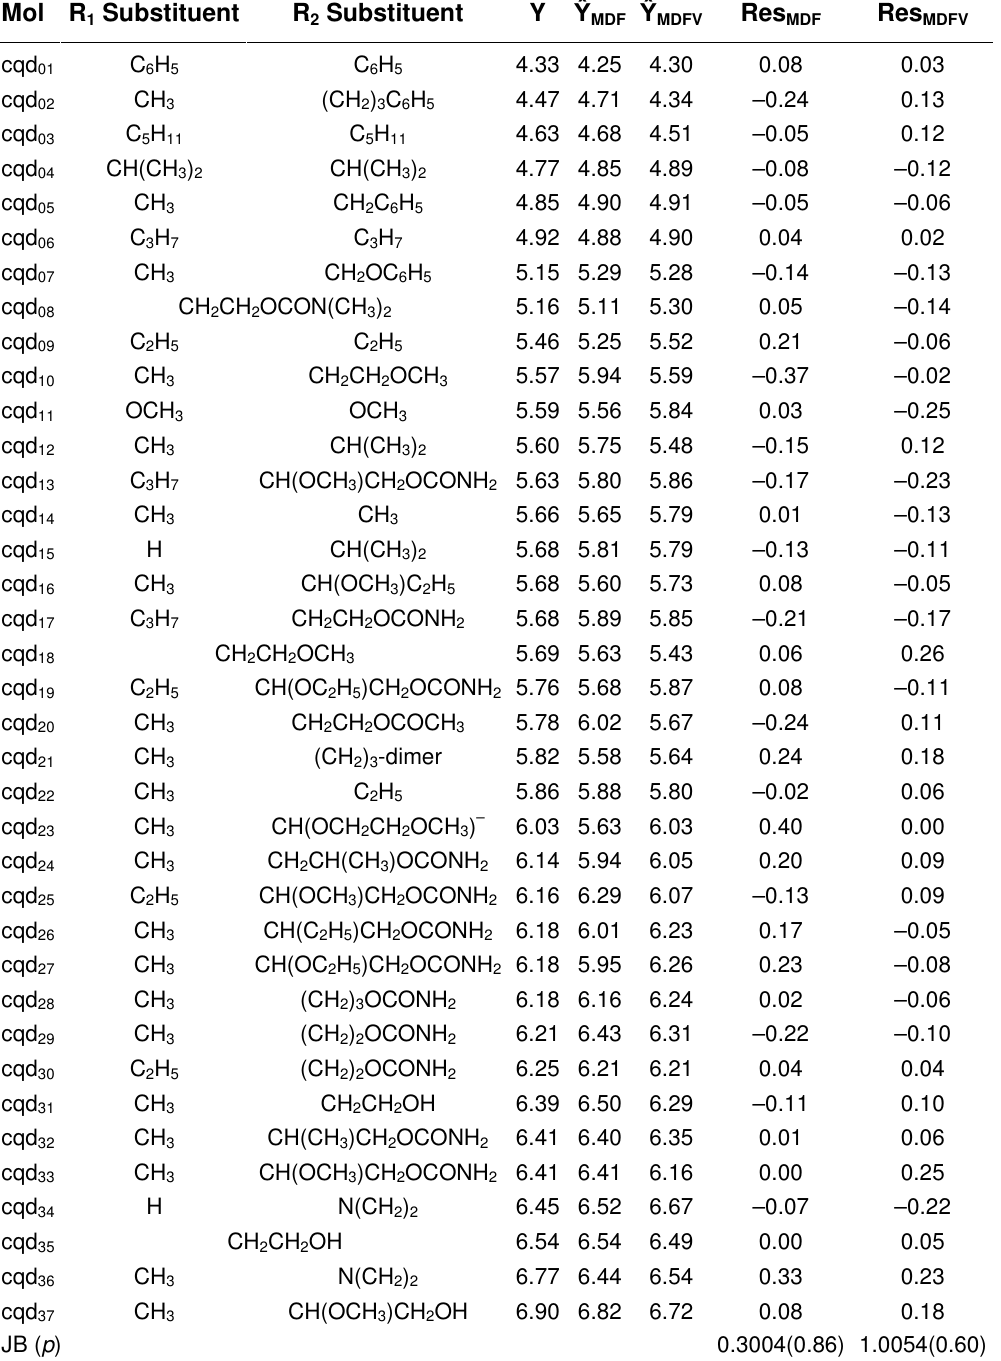
Carboquinone Derivatives, Observed and Estimated Activities, and